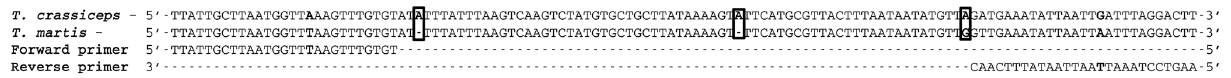
Figure 3. Sequence of the 12S rRNA gene from T. martis and T. crassiceps ampli fi ed by the Tcm-VG primer pair. Differences between the sequences of the two parasites are in bold, and those allowing us to distinguish species are